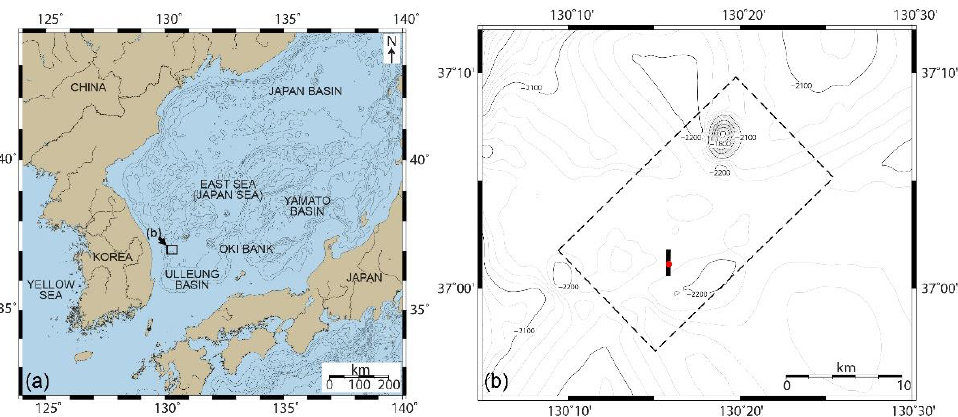
Figure 1. ( a ) East Sea (Japan Sea) physiographic map. The box represents the study area shown in ( b ). ( b ) Bathymetry of the study area (covering two 3D seismic survey sites) with the UBGH2-6 well location. The dashed and solid boxes indicate the original survey areas of CS3D and HS3D, respectively, shown in Figure 2. The solid red circle indicates the UBGH2-6 well location. Contours are in meters.